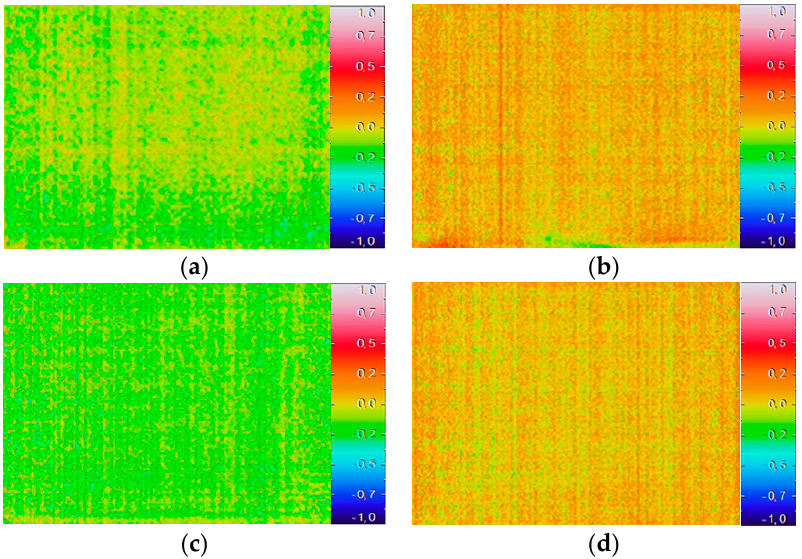
Figure 11. Image subtraction considering, as a reference, the previous image: ( a ) t = 0.5 h; ( b ) t = 2.5 h; ( c ) t = 9 h; ( d ) t = 24 h.